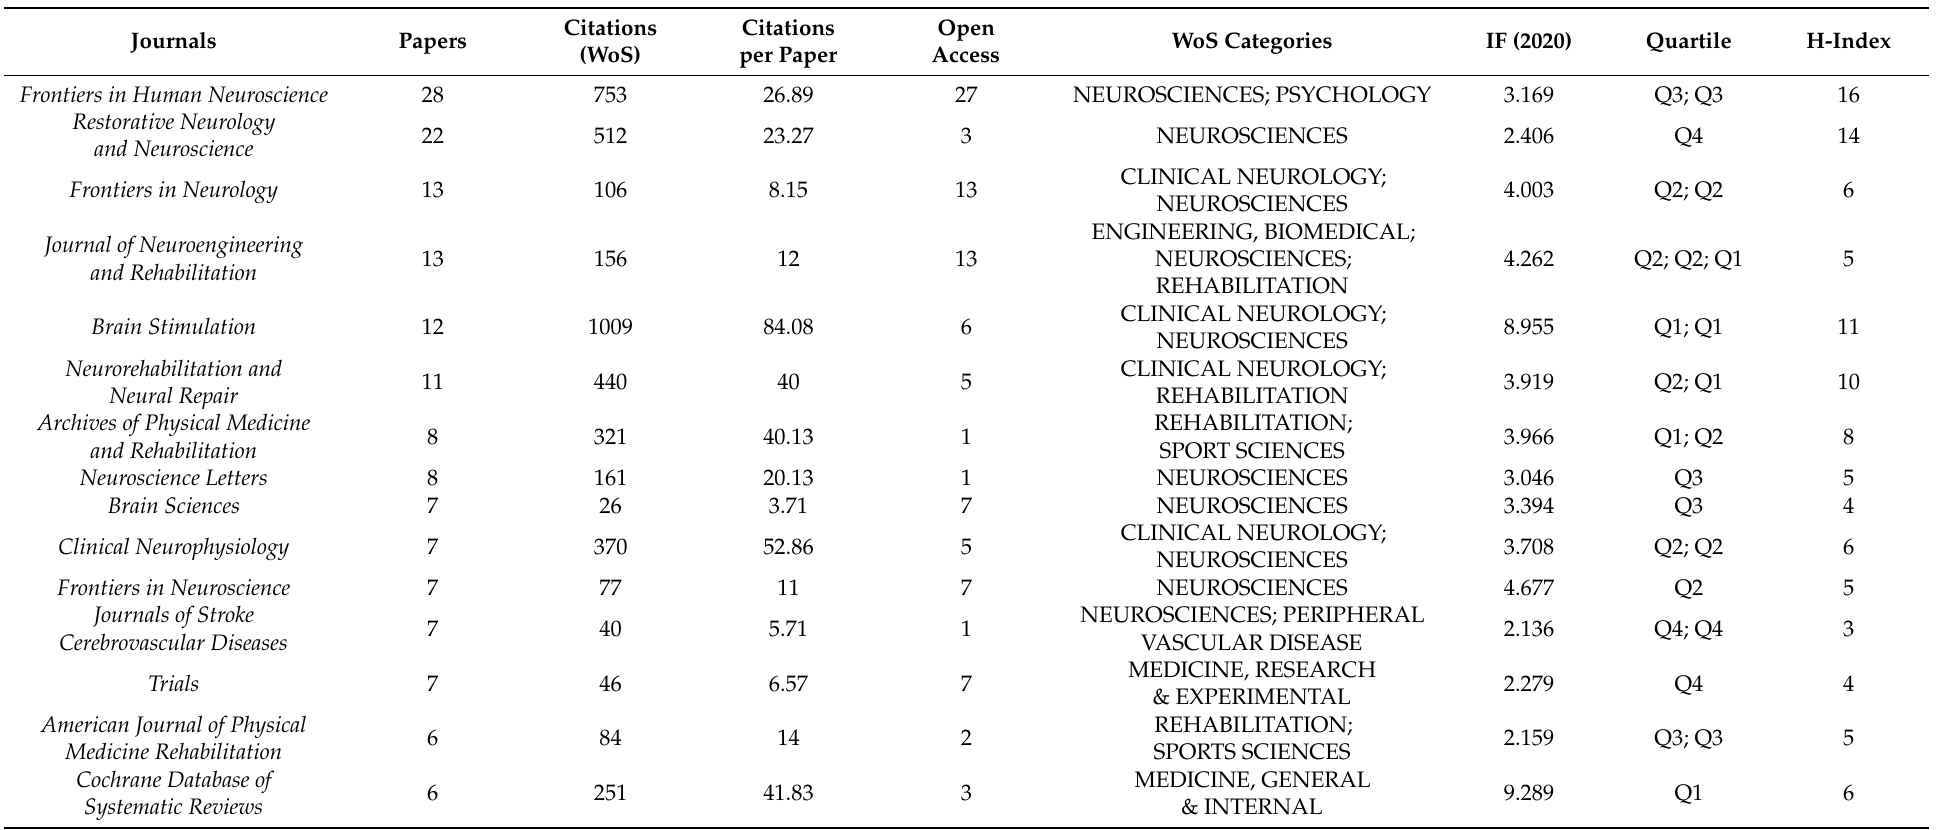
Table 1. The top 15 paper journals based on the number of